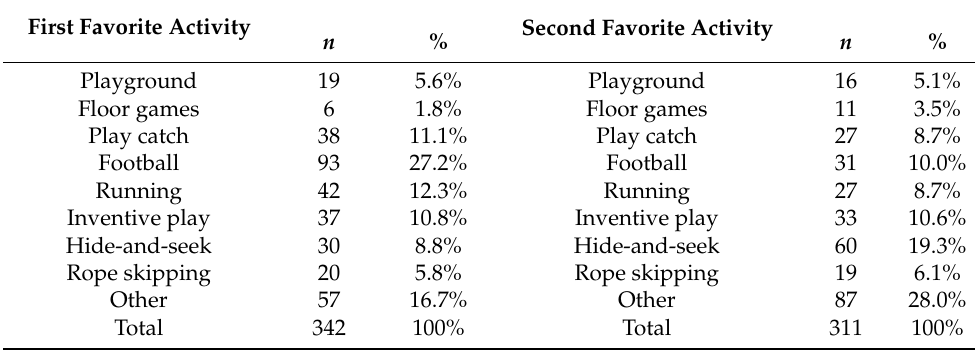
Table 3. First and second preferred activities in primary school recess in the pandemic.